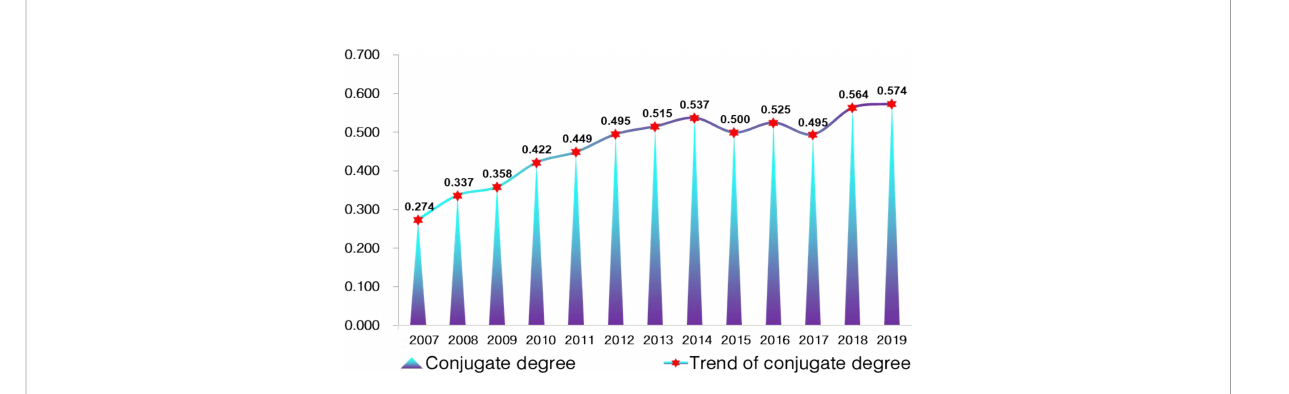
FIGURE 5 conjugate degree of marine composite system in Shandong Province from 2007 to 2019.